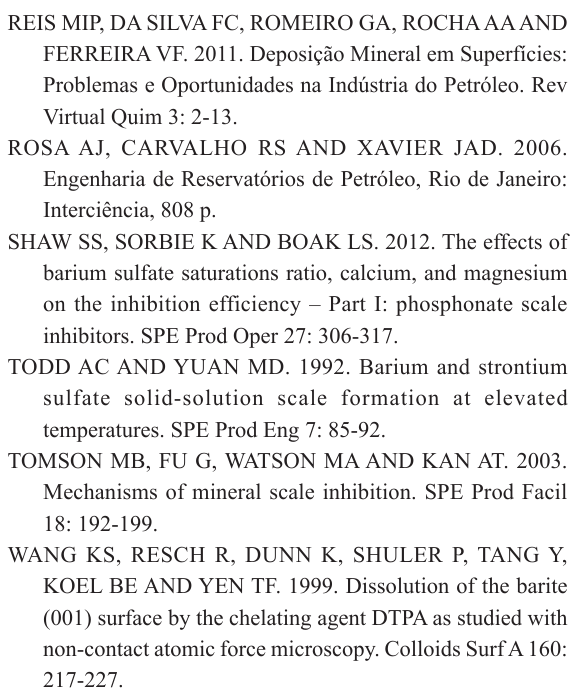
Figure S1 - SEM of barite before dissolution test, with resolution of 40x ( a ); SEM of barites after dissolution tests at 80 °C and 12h: in 10 DTPA% solution , with resolution of 50x ( b ); in 15 DTPA% solution, with of 50x ( c ); in 25 DTPA% solution, with resolution of 60x ( d ). Figure S2 - ( a ) X-ray spectrum and chemical composition of region marked; ( b ) SEM of rock, in detail can be observed precipitate BaSO crystals (resolution of 4